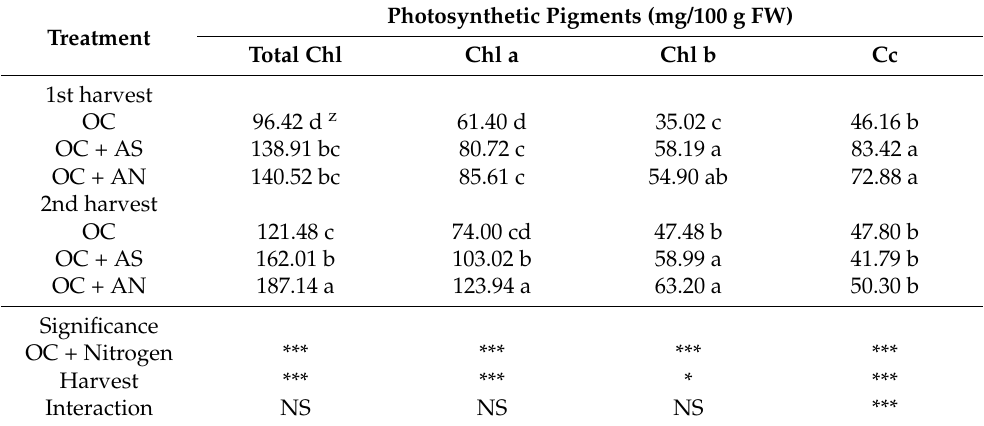
Table 4. Effect of organic compost combined with inorganic nitrogen fertigation on leaf photosynthetic pigments